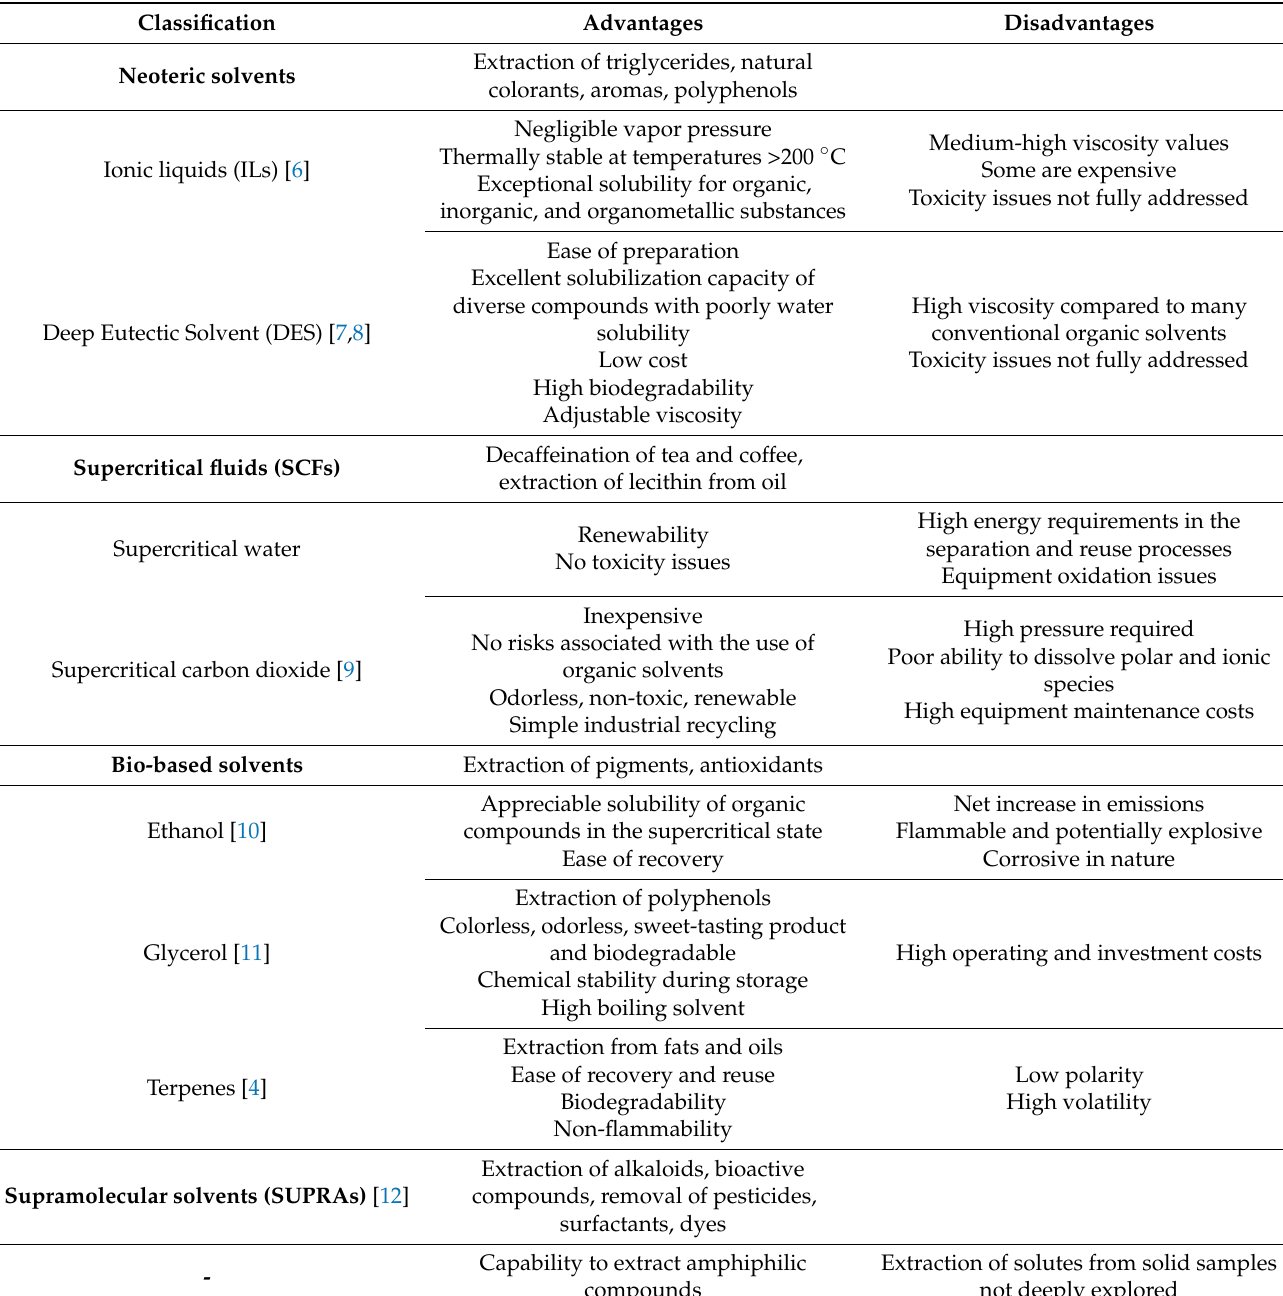
Table 1. Green solvents categories with their respective advantages and